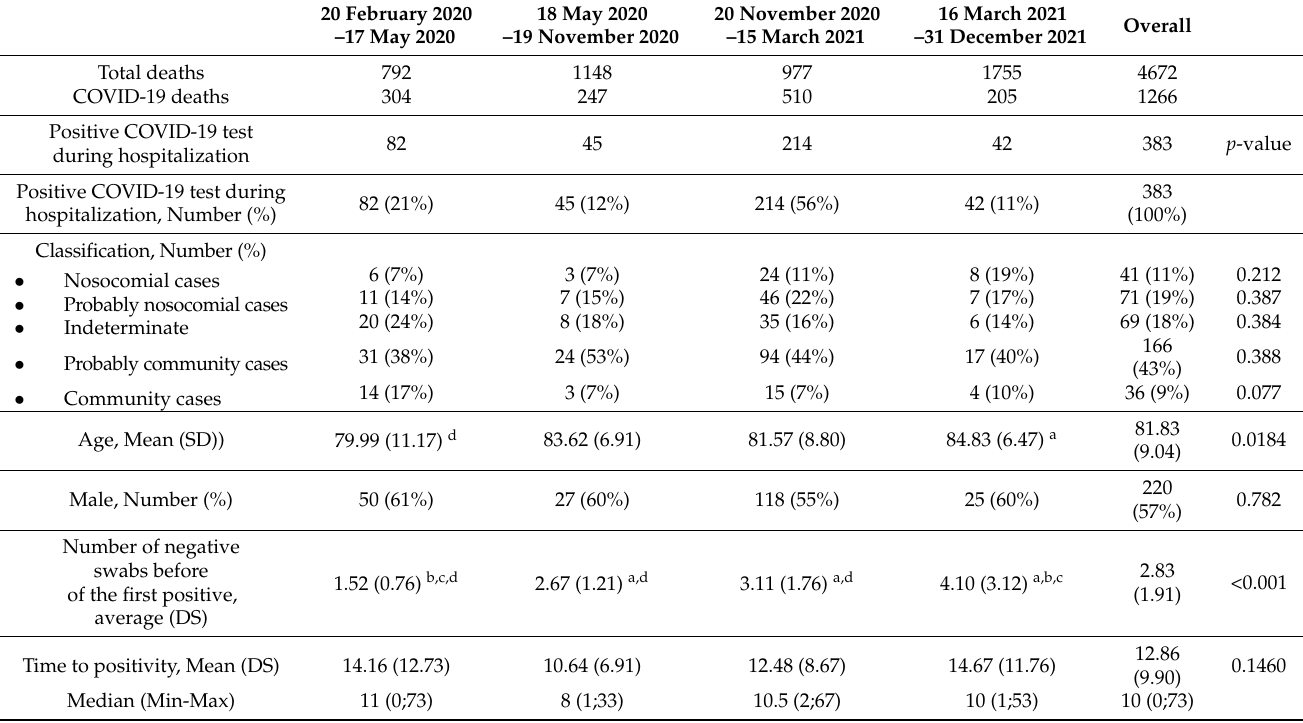
Table 1. Descriptive statistical representation of the results obtained in the various pandemic